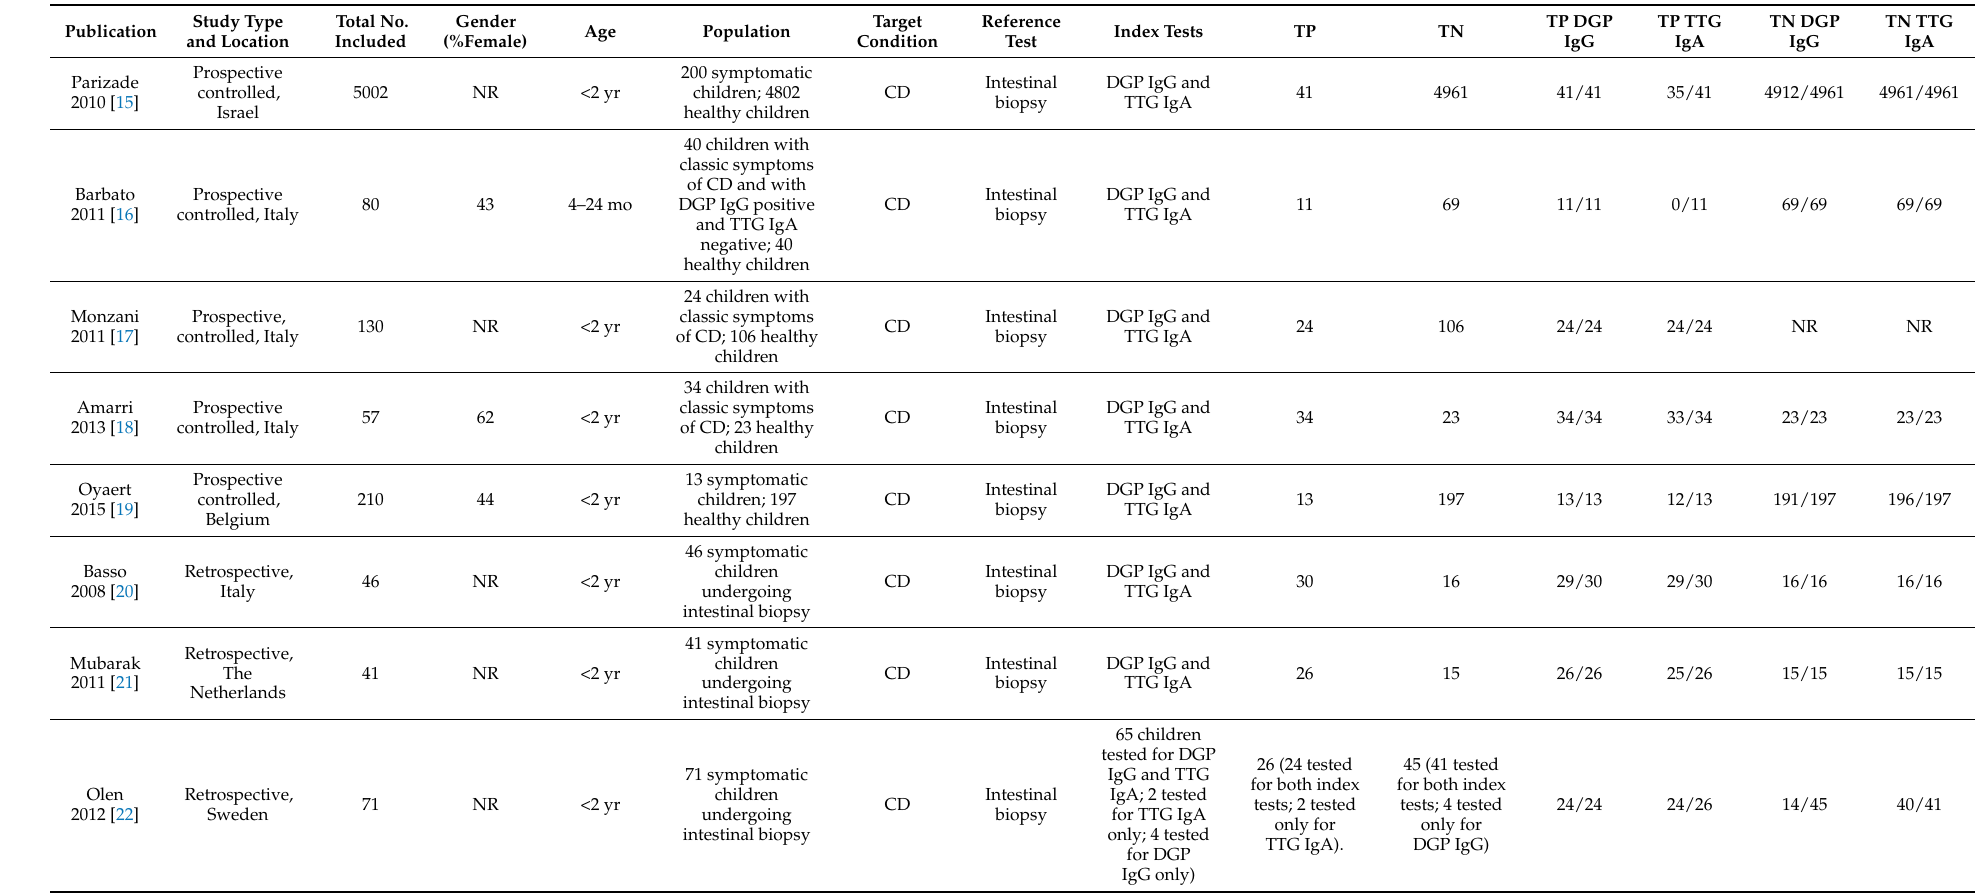
Table 1. Characteristics of included